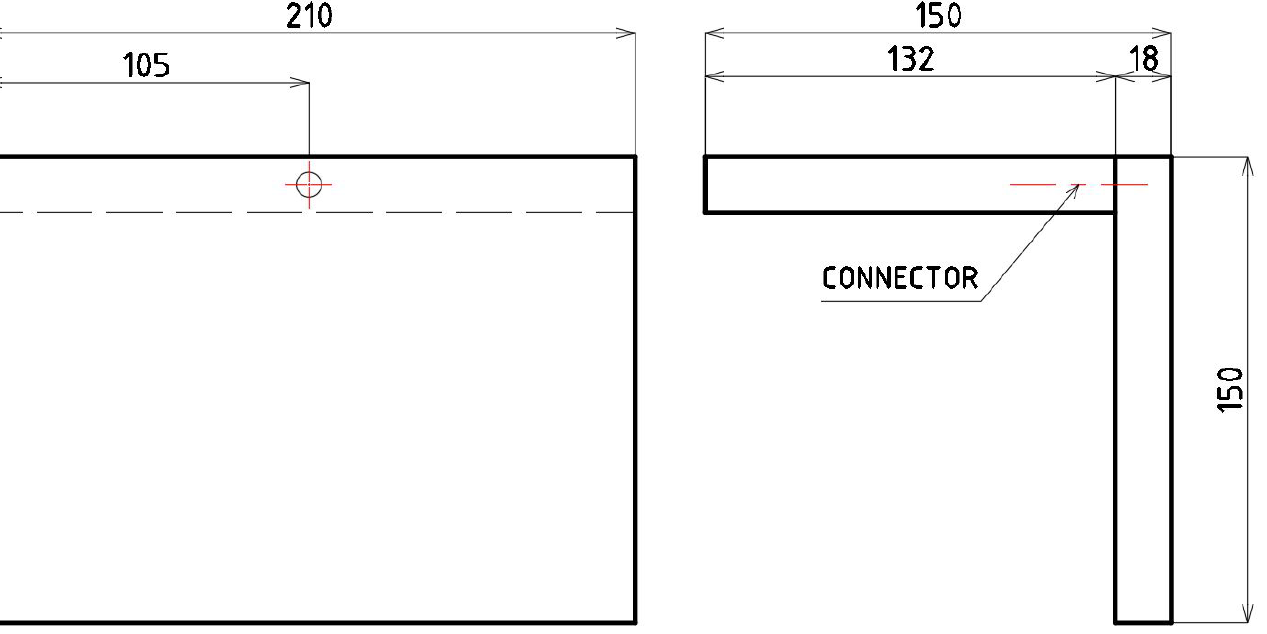
Figure 1. The shape, dimensions, and the loading of a case-type furniture sample used in the reliability tests (dimensions are given in mm).